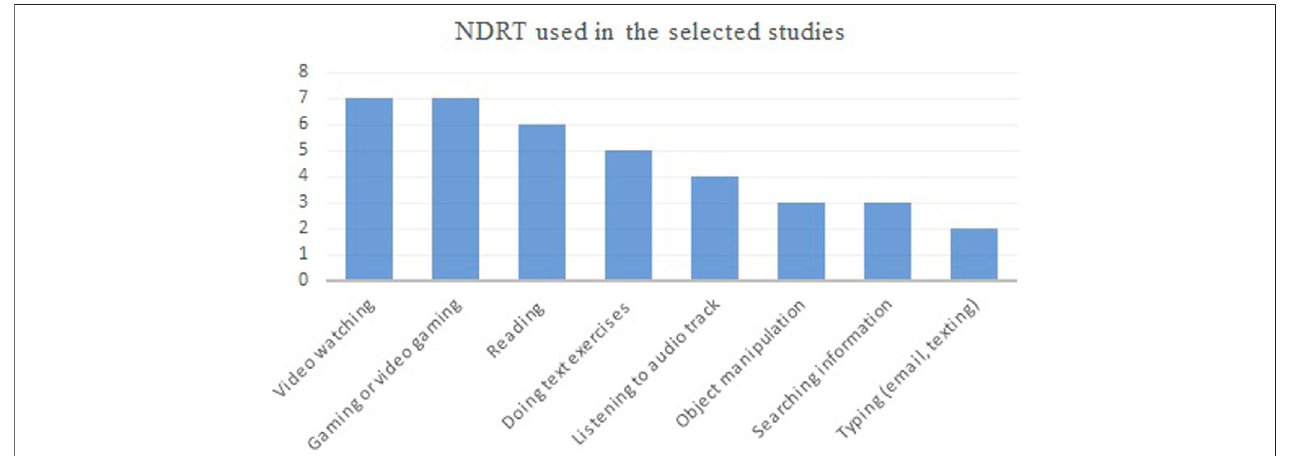
FIGURE 3 | Illustration of the recurrence of the NDRTs used in the selected